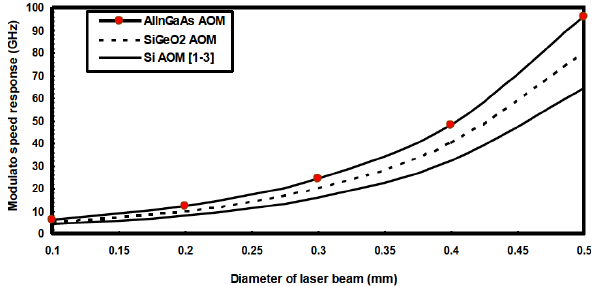
Figure 6: Variations in modulator transient time response in relation to laser beam diameter for the previous and proposed AOMs at room temperature